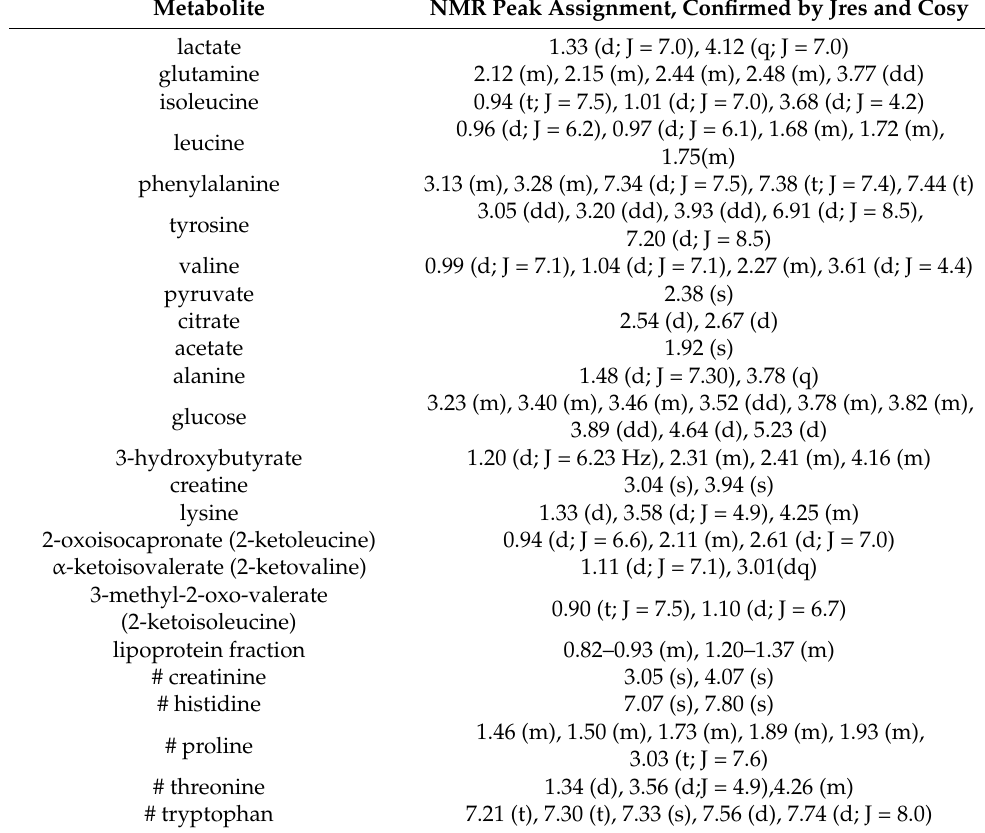
Table 2. Chemical shifts (in ppm), J couplings (in Hz), and multiplicities (s, singlet; d, doublet; t, triplet; q, quartet; m, multiplet; dd, doublet of doublets; dq, doublet of quartets) for the pool of metabolites identified in blood plasma. Signals marked with # were not suitable for quantitative